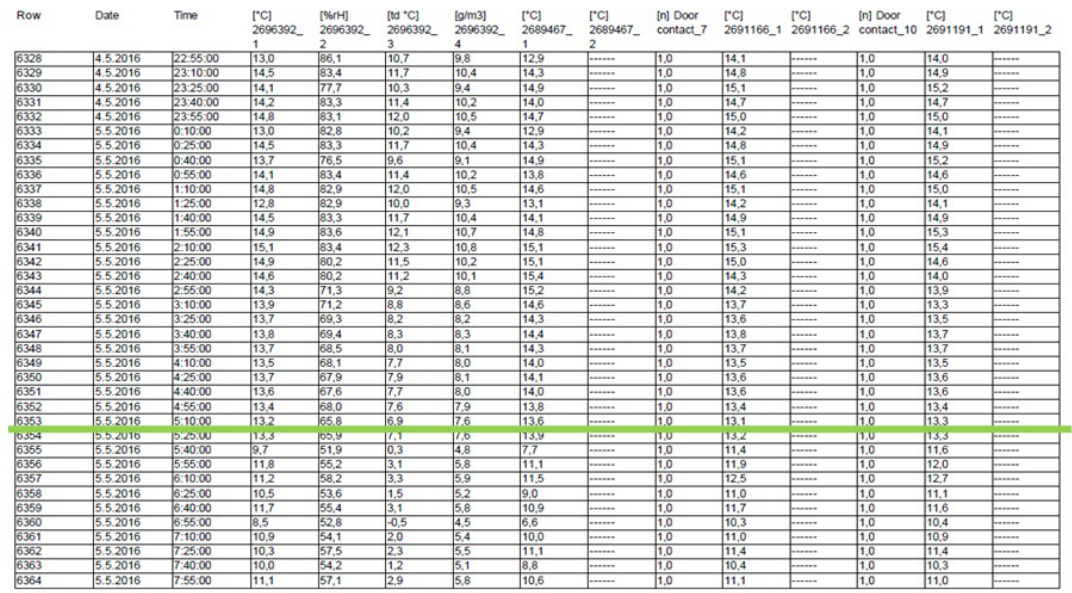
Figure 3: Transport temperatures of bananas and eggs. Transport between Madunice to Üllo and between Üllo to Vel’ký Krtíš.